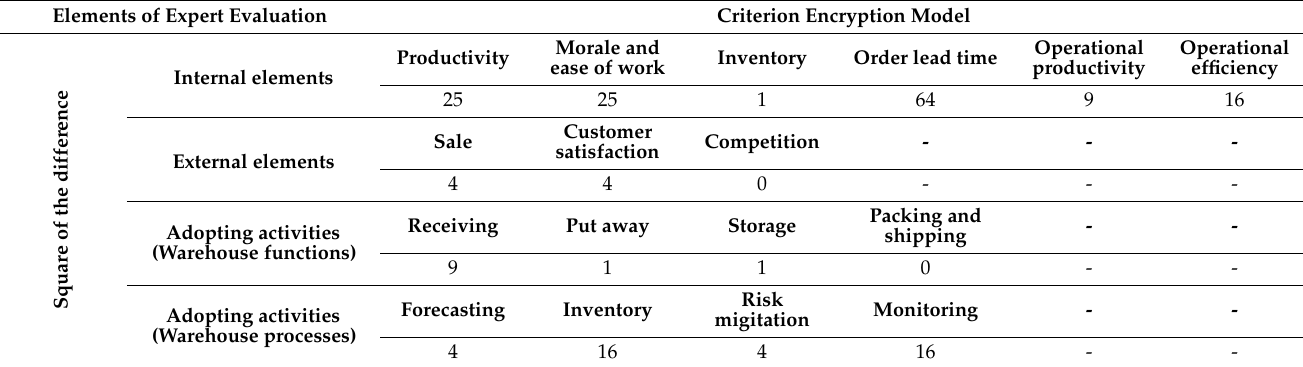
Table 10. Expert judgment difference squared